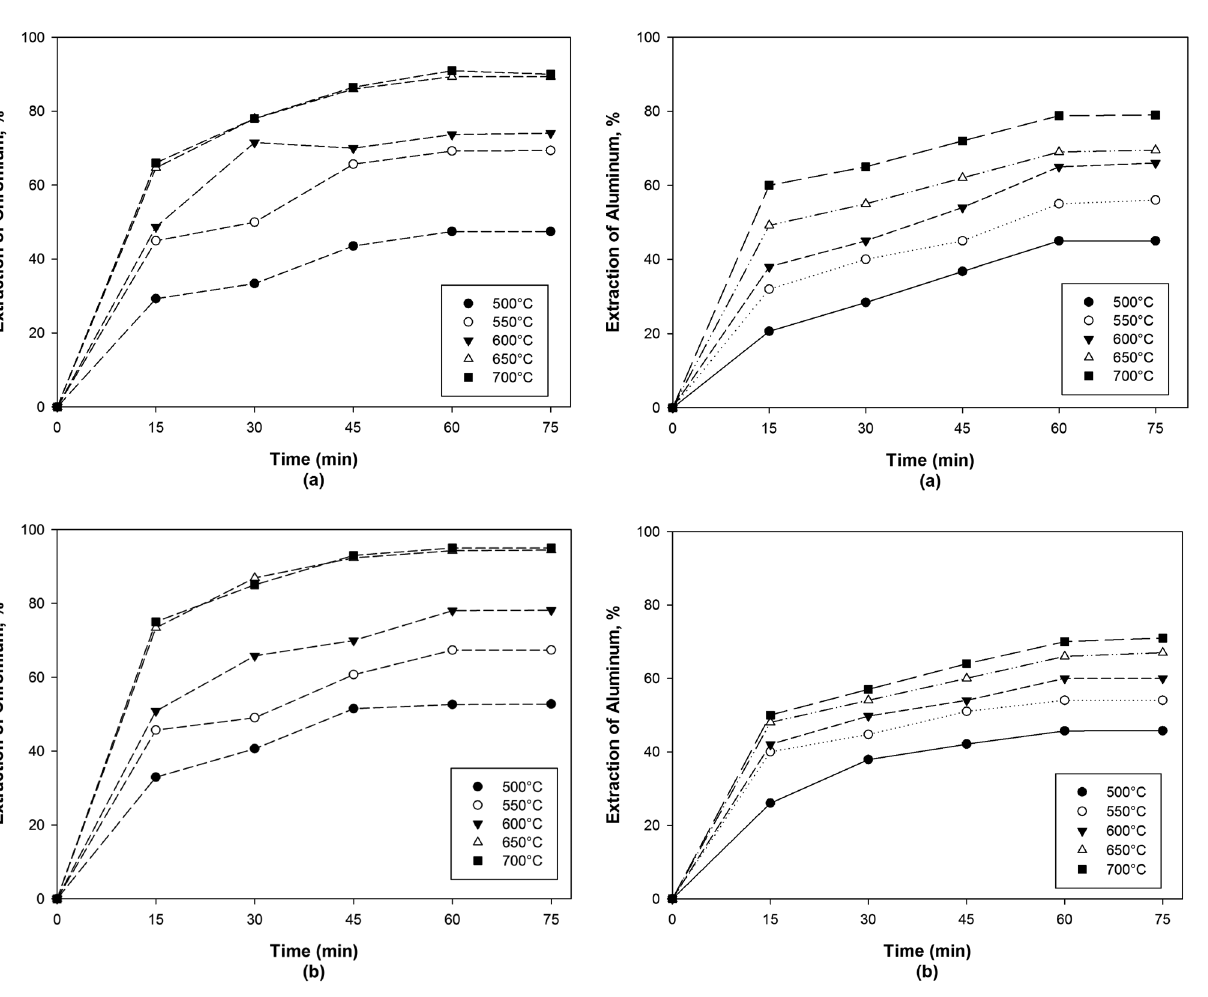
Fig. 7: The effect of fusion time on the extraction percentage of aluminum: (a) 2 g of NaOH, (b) 4 g of NaOH (1 g